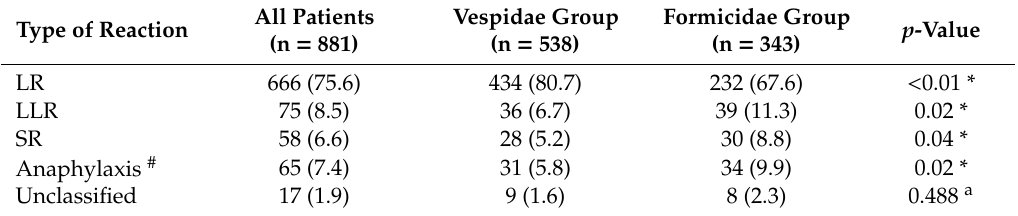
Table 3. Comparison of the stinging reactions between the two study